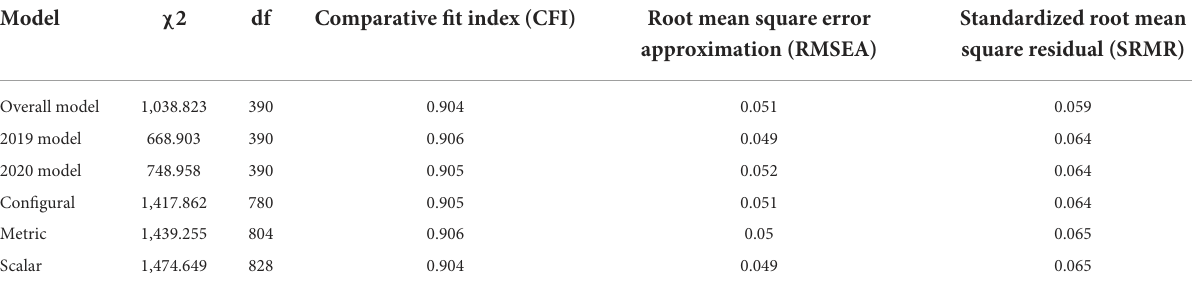
TABLE 2 Results of invariance